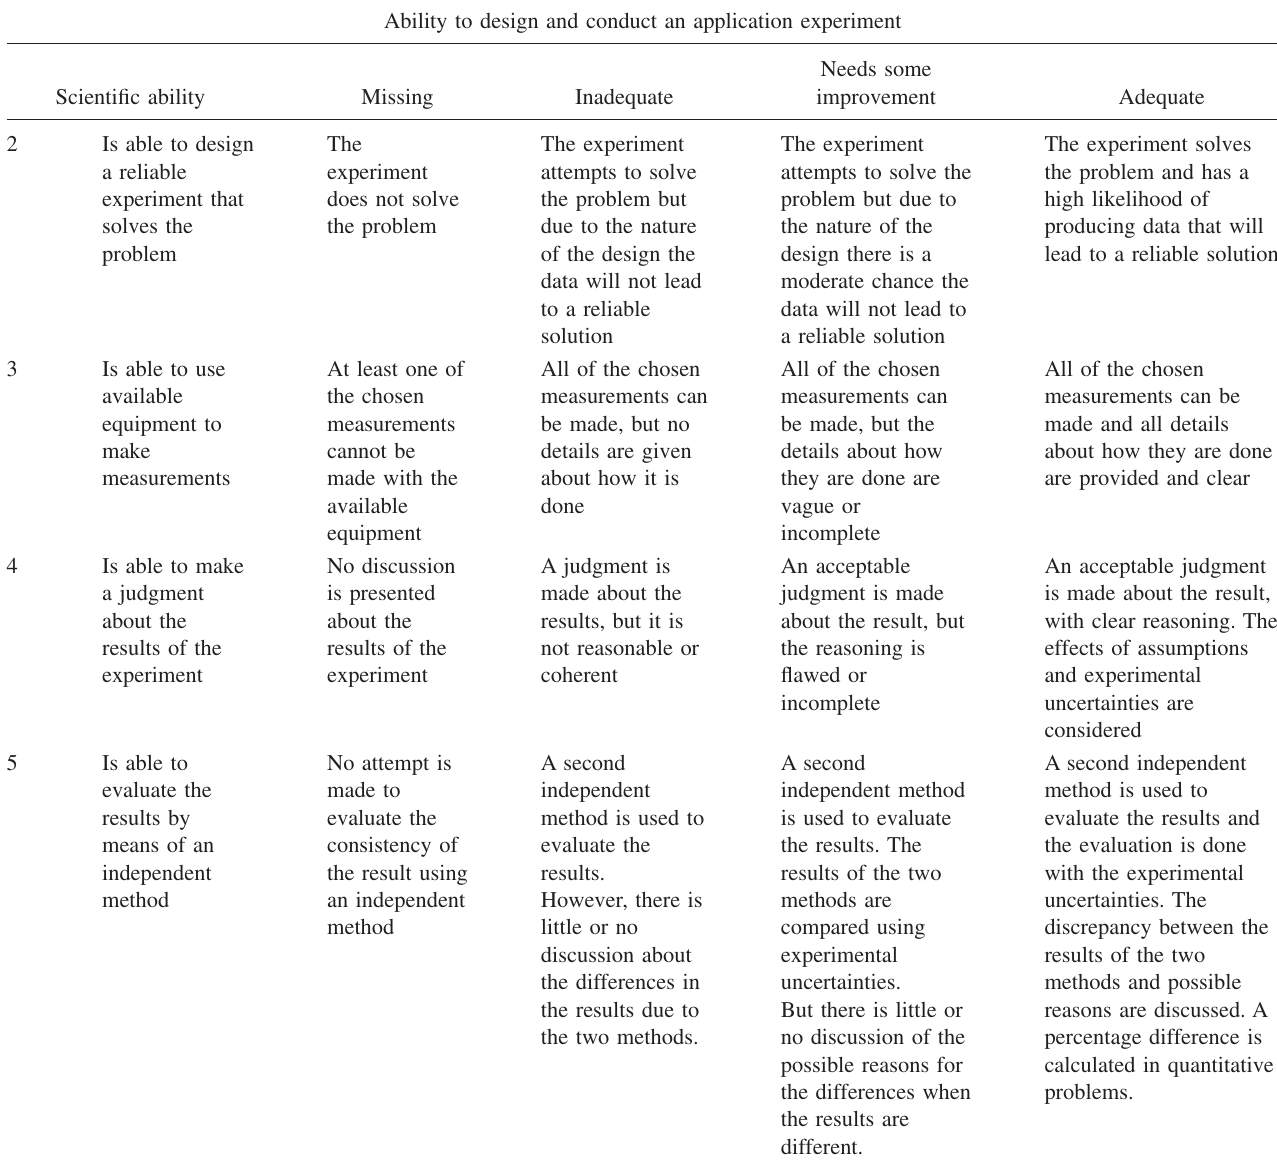
TABLE I. An example of some scoring rubrics to assess the scientific abilities. Ability to design and conduct an application